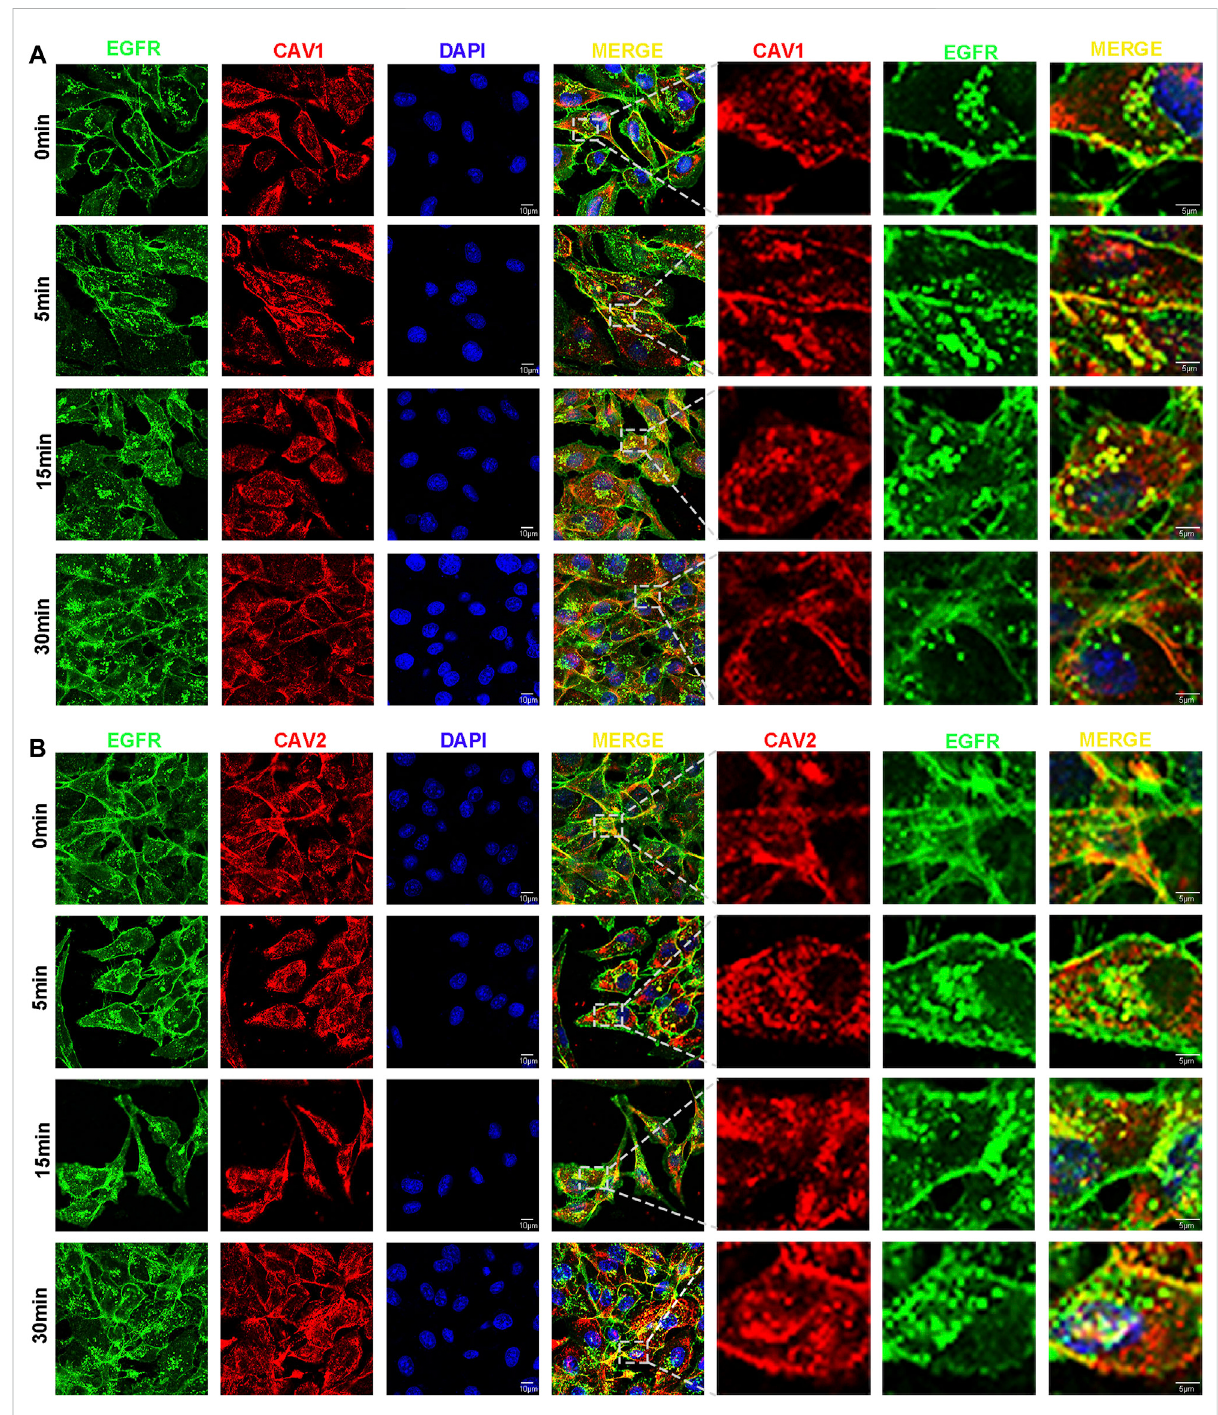
FIGURE 13 CAVs participate in the process of EGFR endocytosis. (A,B) After serum starvation for 12h, cells were stimulated with EGF (50 ng/ml) for 0, 5, 15, and 30 min. The cells were fi xed and blocked, and primary and secondary antibodies were applied (EGFR stained with green, CAV1 (A) and CAV2 (B) with red, and nuclei with